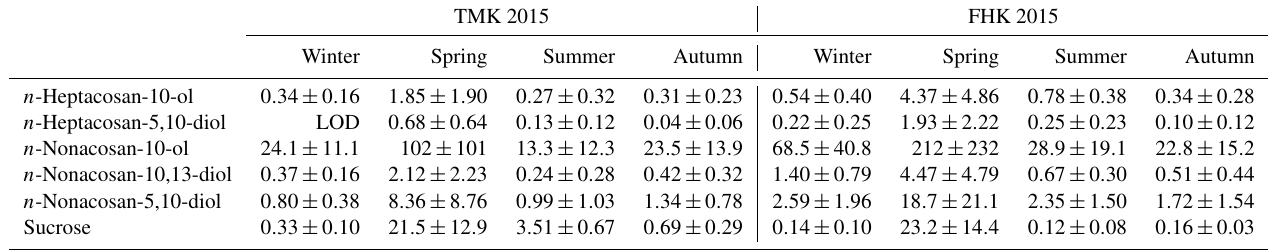
Table 1. The mass concentrations ∗ of the secondary fatty alcohols (SFAs) identified and sucrose in TSP at TMK and FHK sites in each season in 2015.